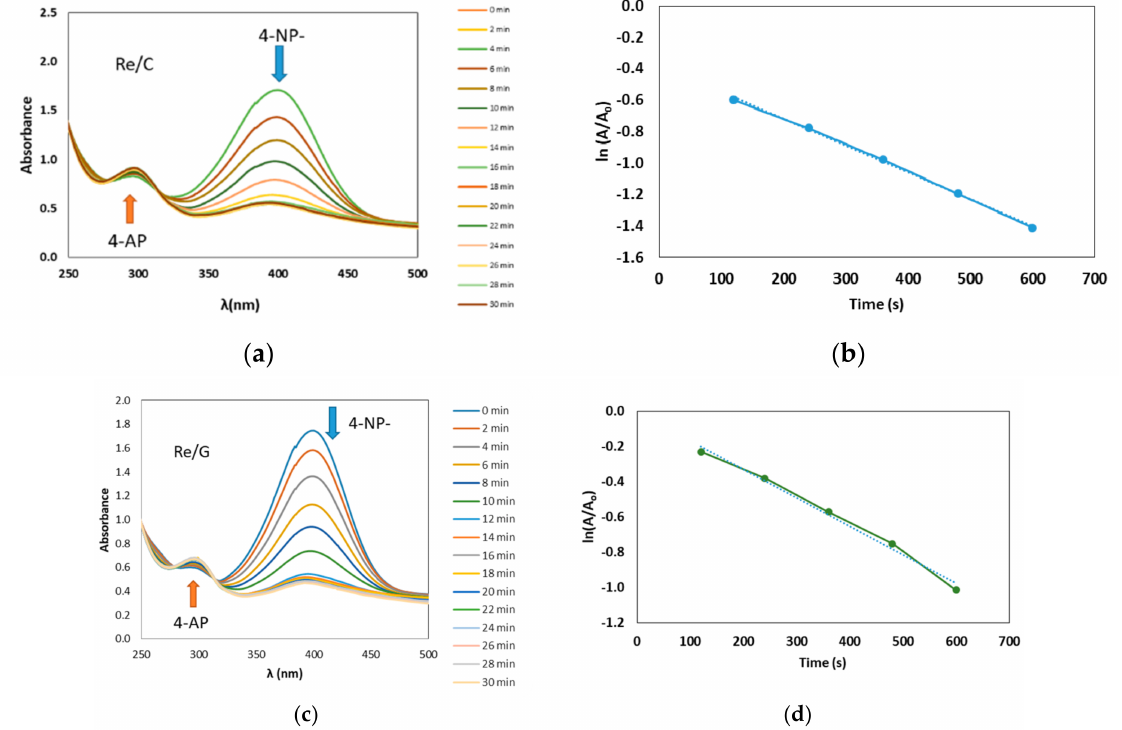
Figure 3. Reduction of 4-NP to 4-AP ( a , c ) Monitoring UV-Vis absorption spectra (2 min intervals) for the catalytic reduction of 4-NP using supported Re nanoparticles (Re/C and Re/G, respec- tively). ( b , d ) Absorption dependence on time. Conditions: 15 W power, [4-NP] = 7.5 × 10 − 3 M; [NaBH 4 ] = 0.169 M; n Re/C = n Re/G = 0.2 µ mol of Re immobilized at the carbon support; T = 50 ◦